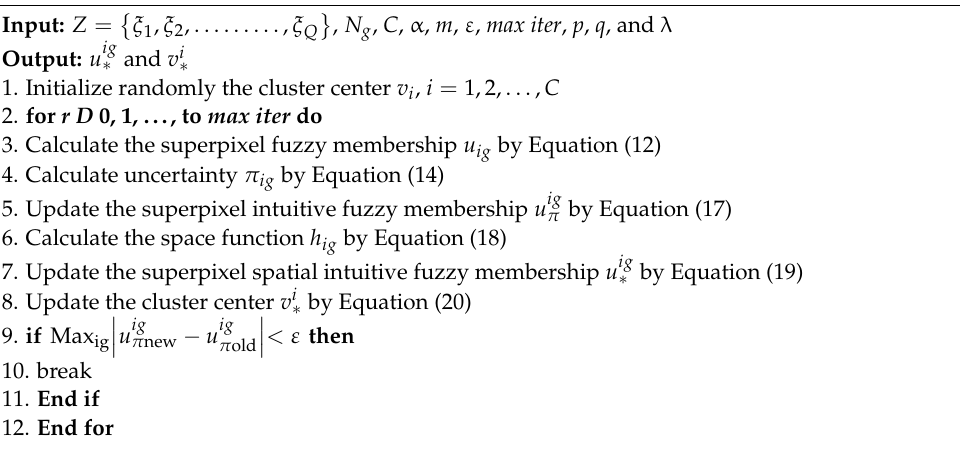
Algorithm 1 The proposed superpixel spatial intuitionistic fuzzy C-means (SSIFCM).